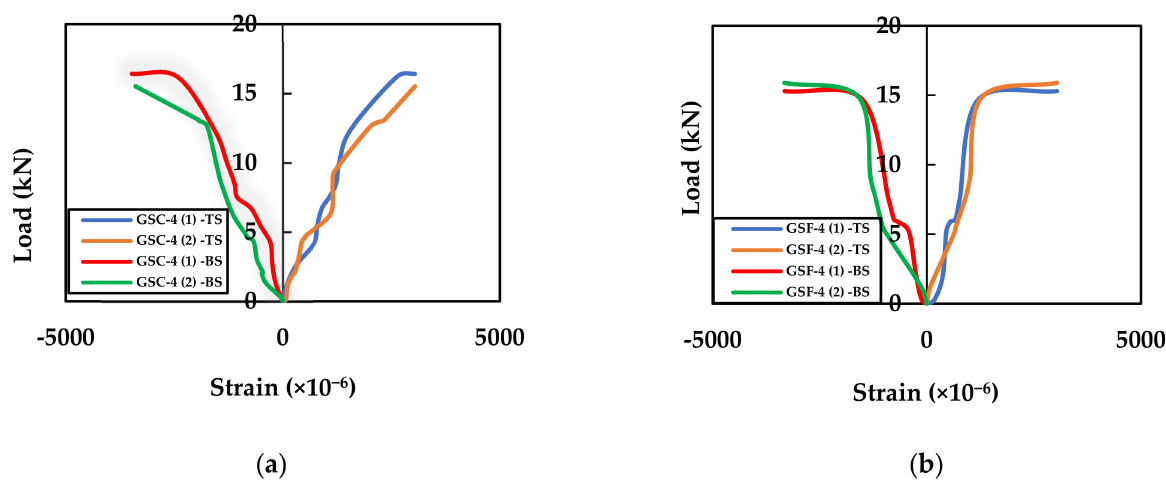
Figure 14. Load–strain behaviour of ( a ) GSC-4 and ( b ) GSF-4. TS—top strain, BS—bottom